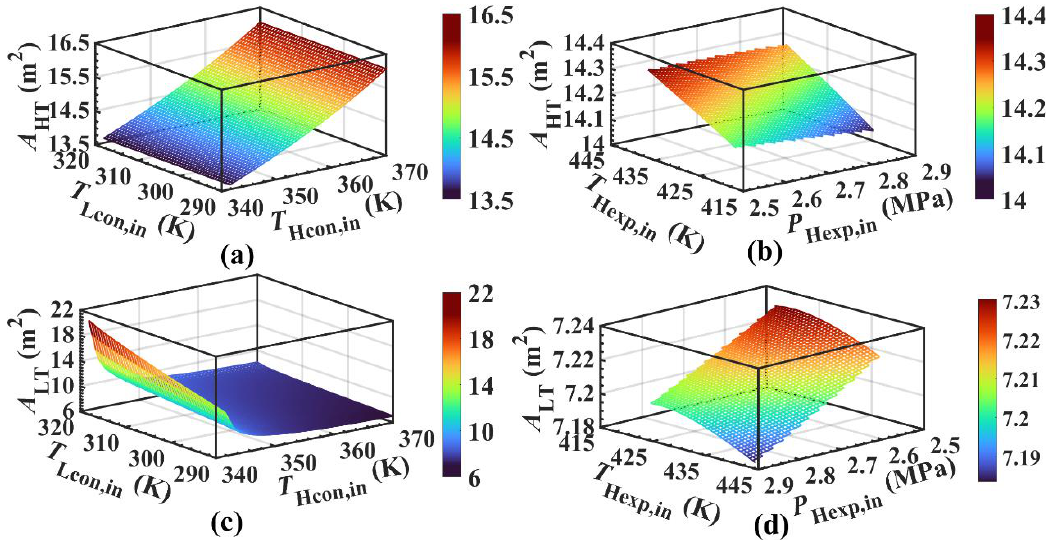
Figure 9. Influence characteristics of key variables on the heat transfer surface of the HT cycle and the LT cycle. (a) Effect the characteristics in the condenser inlet temperature of different loops on the heat transfer surface for the HT cycle. (b) Effect characteristics of heat transfer surface in the HT cycle. (c) Effect characteristics in different loops on the heat transfer surface of the LT cycle. (d) Effect characteristics of the heat transfer surface of the LT cycle.